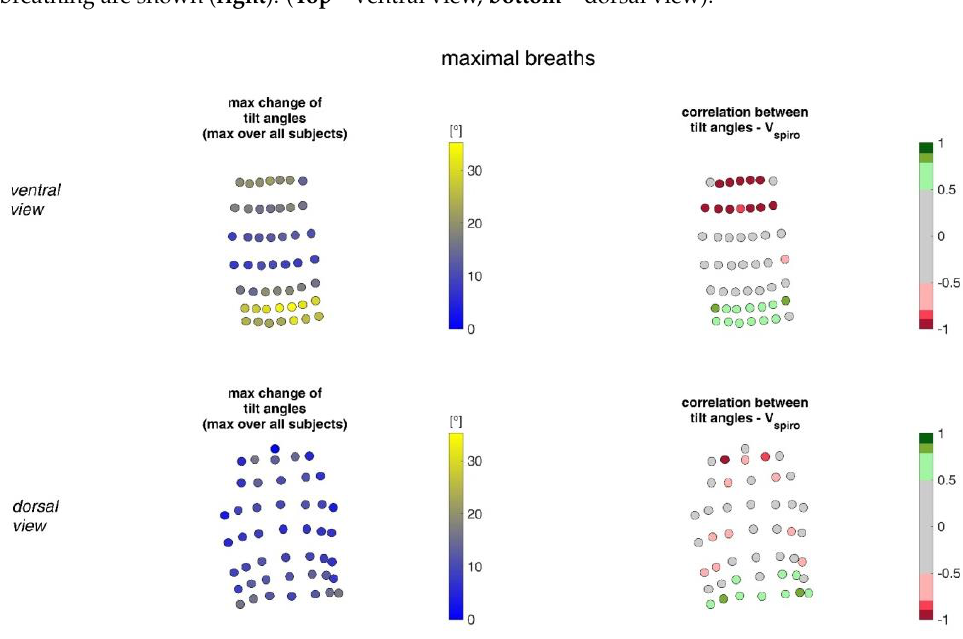
Figure 17. The maximal tilt angle changes amongst all subjects during shallow breathing (left) and the corresponding correlation with the spirometer volume V spiro of all subjects during shallow breathing are shown (right). (Top - ventral view, bottom - dorsal view).